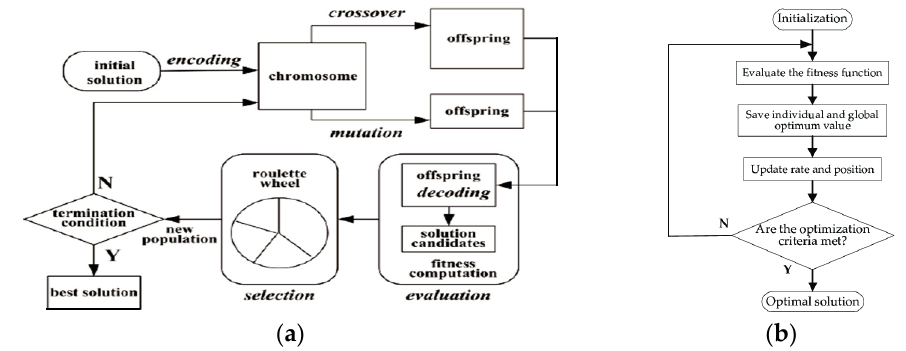
Figure 1. Standard Genetic Algorithm, ( a ) GA Structure; ( b ) GA Algorithm.